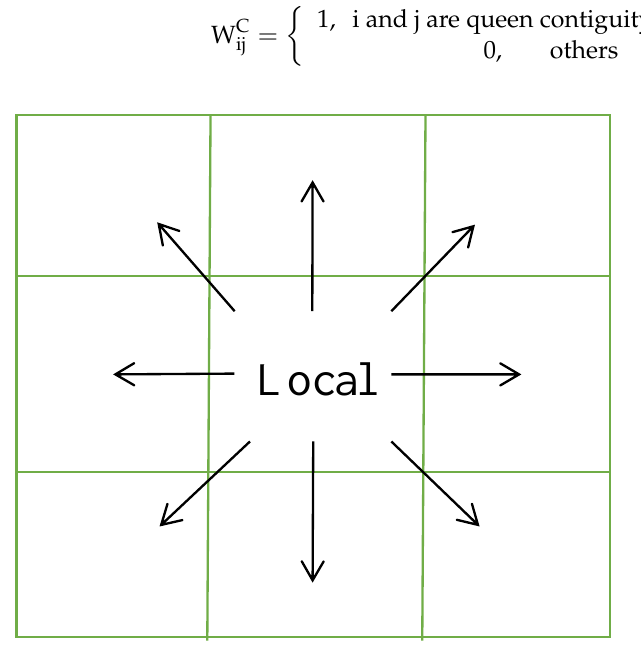
Figure 2. Queen Figure 2. Queen contiguity.